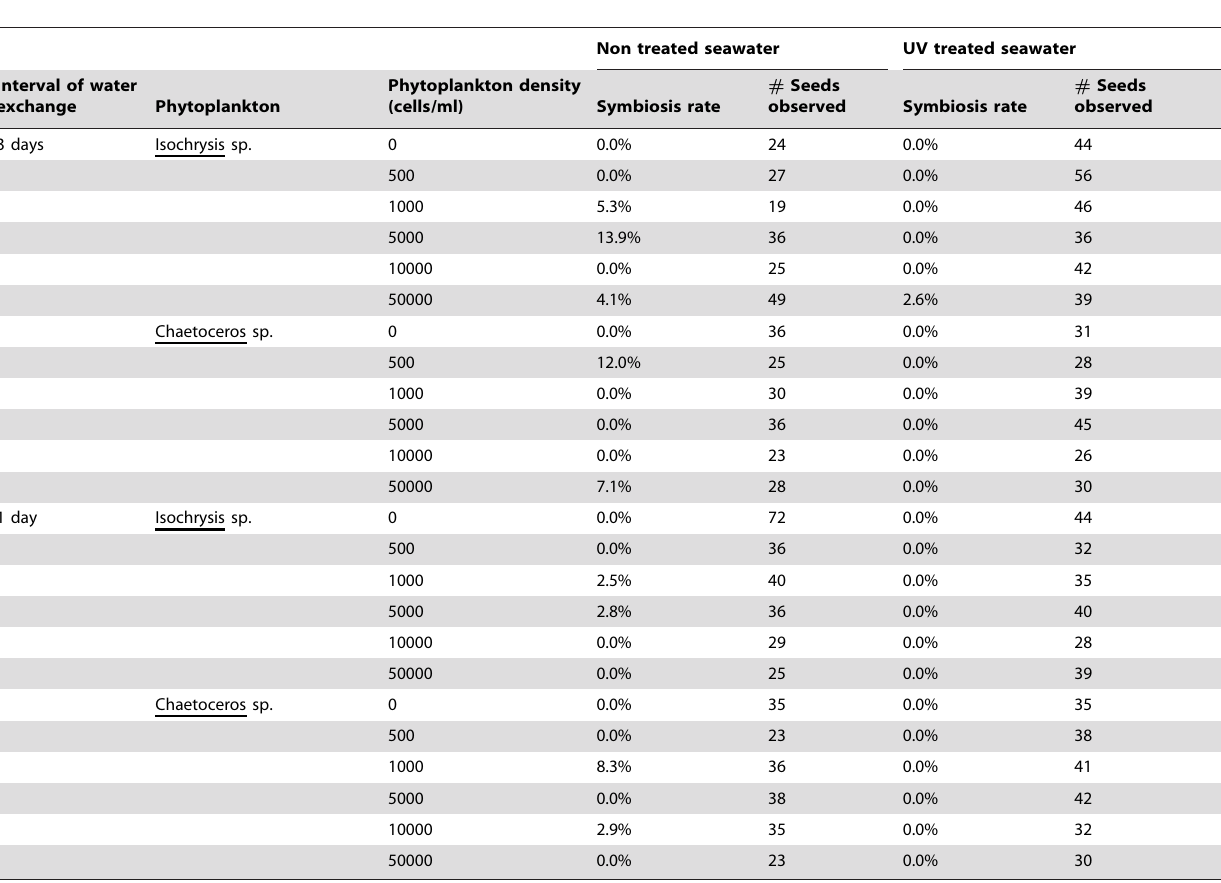
Table 1. Symbiosis rates of Tridacna crocea in Run 1 of the feeding